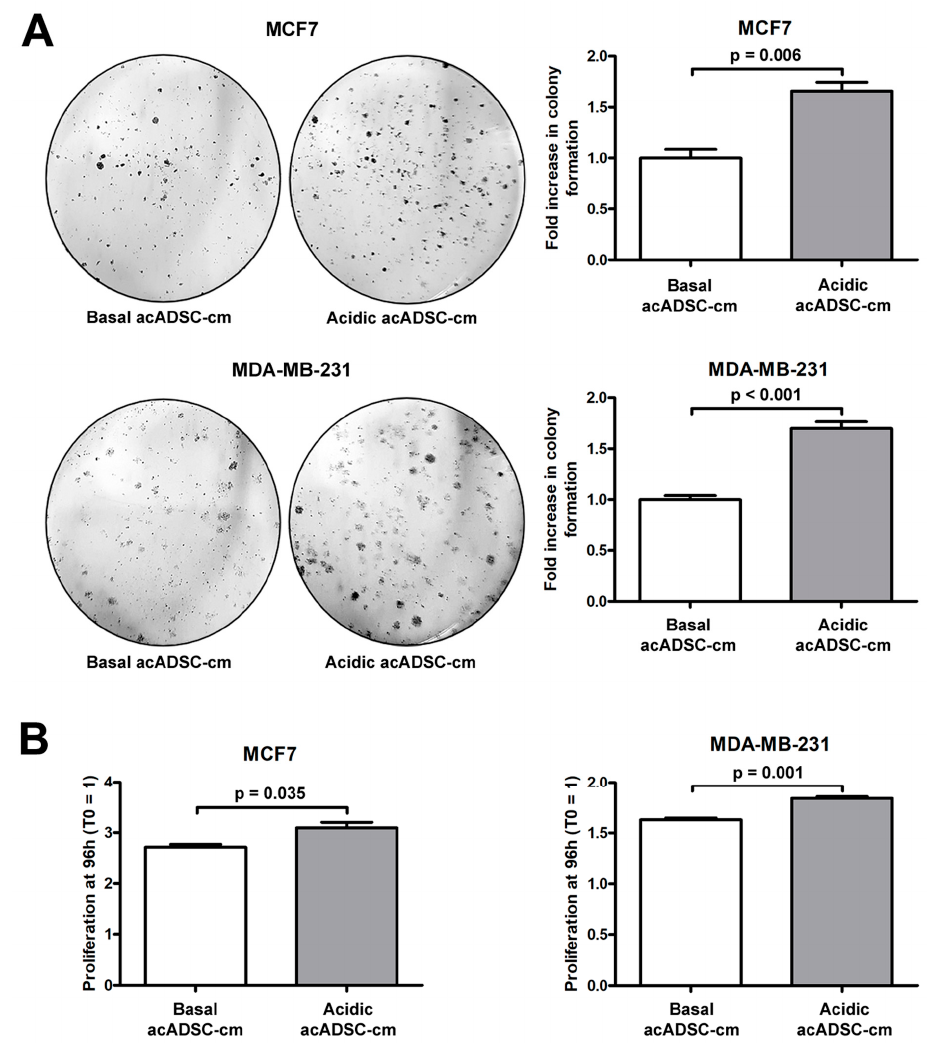
Figure 8. ( A ) Representative images and relative quantification charts of colony formation by MCF7 and MDA-MB-231 cells cultured for 10 days in conditioned media produced by adipocyte-committed adipose-derived stem cells (acADSCs) grown either under basal (pH 7.4) conditions (basal acADSC-cm) or under lactic acidosis (acidic acADSC-cm). ( B ) Proliferation charts of MCF7 and MDA-MB-231 cells cultured for 96 h in basal or acidic acADSC-cm. The cell proliferation rate before the addition of acADSC-cm (T0) was set to 1, and the other results are normalized to this value. Bars represent the mean ± SEM of three independent experiments ( n = 3 replicates each for colony formation assay, n = 10 replicates each for proliferation assay). Values of p were determined by unpaired Student(cid:31)s t -test.